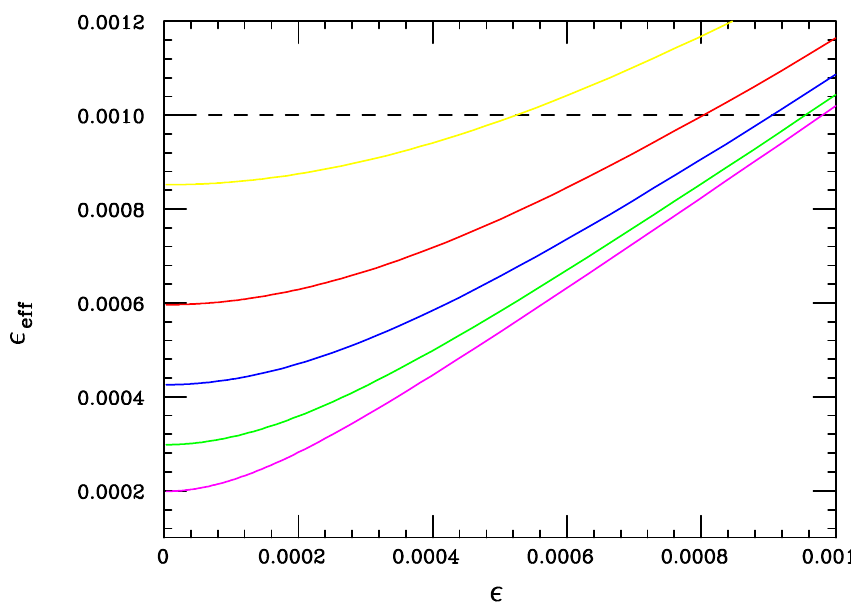
Figure 8 . ‘Effective’ value of (cid:15) obtained when both KM and dark magnetic dipole moments contribute to the e + e − → γV process as a function of the true value of (cid:15) taking α D = 0 . 5 for purposes of demonstration; the limit m 2 /s → 0 has been employed. The curves from top to V bottom assume that Λ e /α D = 175 , 250 , 350 , 500 and 750 TeV, respectively. The horizontal dashed line is the approximate current upper bound from BaBar for invisibly decaying DPs and so defines the presently allowed region of this parameter